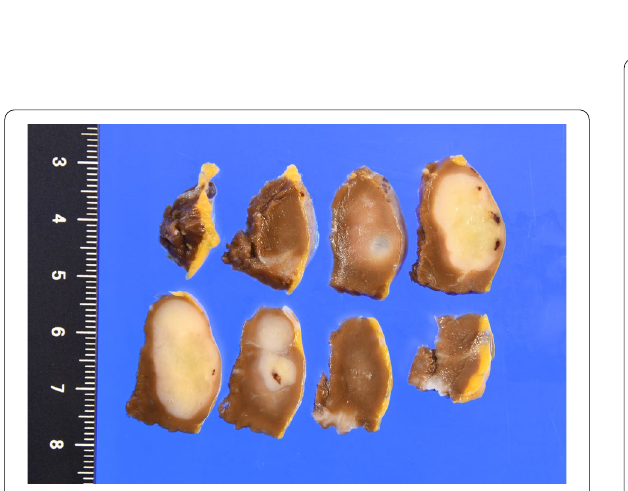
Fig. 5 Macroscopic view of the resected specimen (cut surface) showing the tumor, which was 12